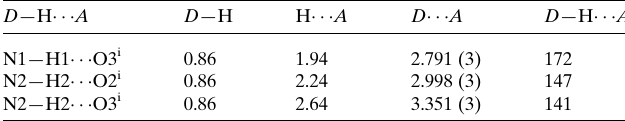
Table 1 Hydrogen-bond geometry (A˚ , (cid:3) ).